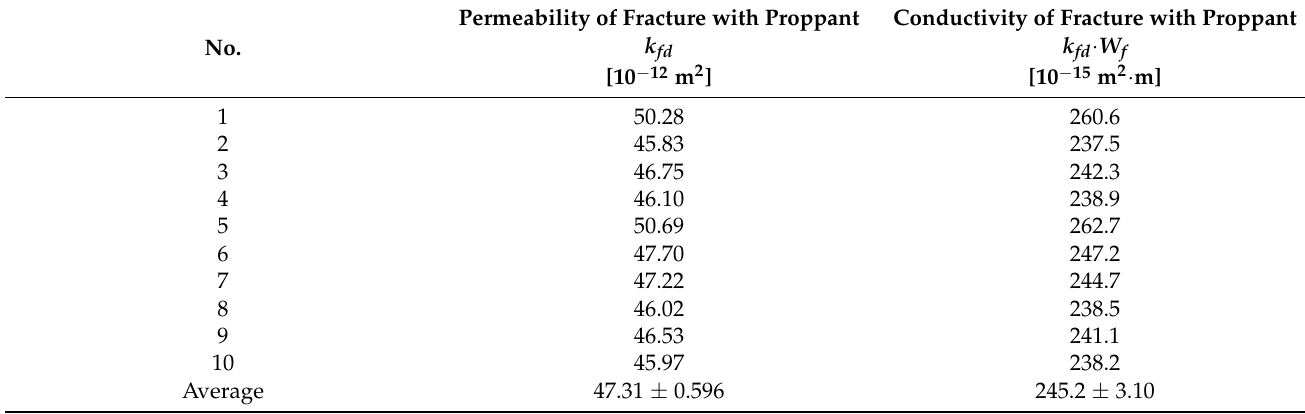
Table 8. The measurement results for the determination of the original conductivity and permeability of the fracture filled with quartz sand 20/40 damaged by the fluid FF1B at 60 ◦ C; compressing stress 27.6